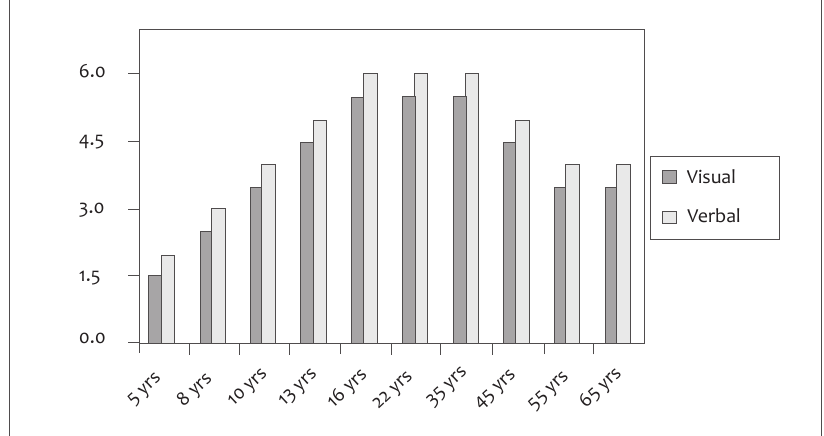
Figure 2: The development of working memory capacity (Adapted from Alloway 2011) (Note: The y-axis represents the number of chunks